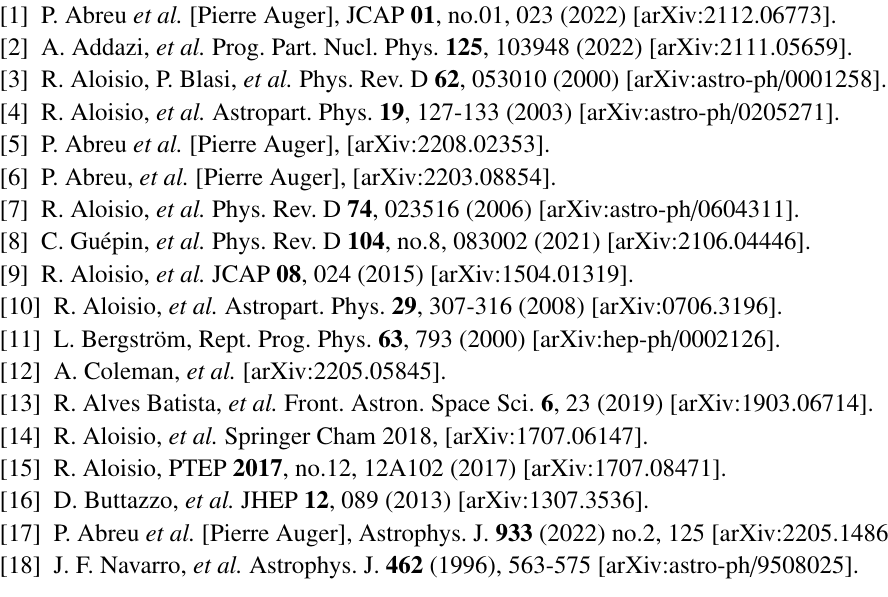
the limits coming from Auger data on the age of the universe at the end of inflation H − 1 di ff erent values of the reheating e ffi ciency (cid:30) = ( Γ φ / H inf ) 1 / 2 , being Γ φ = g 2 decaying amplitude into SHDM ( M φ inflaton mass; g φ inflaton coupling with SHDM) [5,